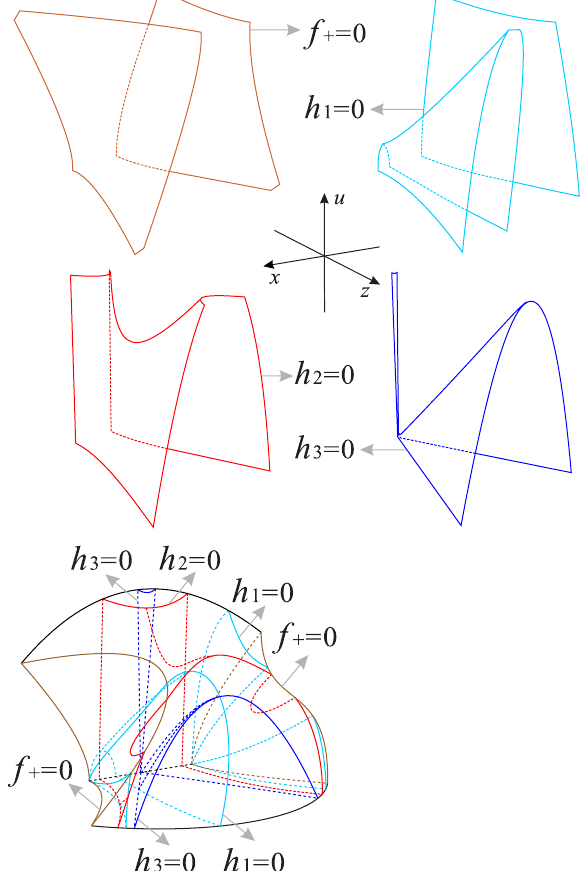
Figure 20. The surfaces h 1 , h 2 and h 3 restricted to the invariant surface f + ( x , z , u ) = 0 and the region